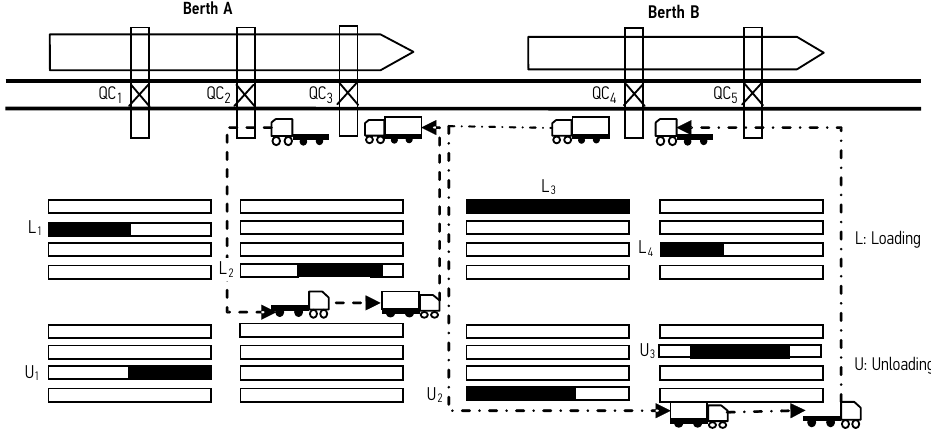
Fig. 1. Process of traditional separate-operation